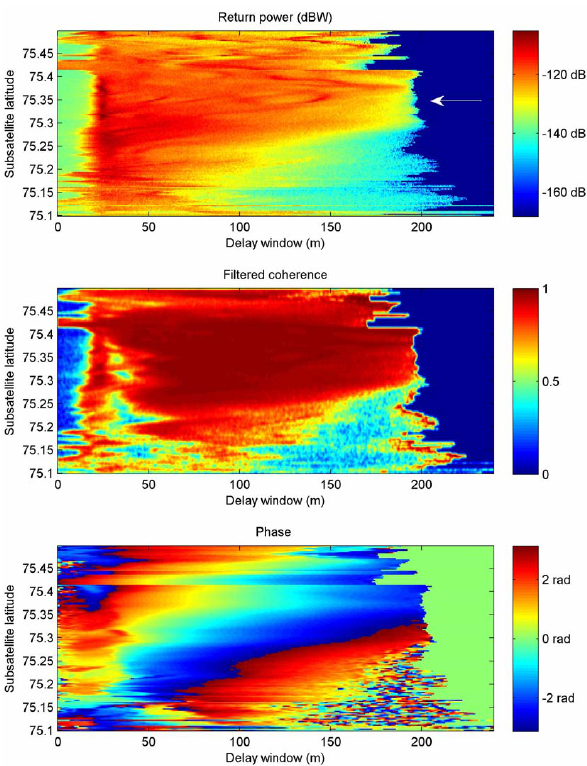
Fig. 5. Illustration of the return power for the central part of the February 23 pass (top), the filtered coherence (middle), and the differential phase (bottom), all as a function of the delay window expressed as a slant range distance. Note that the phase has not been unwrapped at this stage. The white arrow in the upper image of return power indicates the position of the profiles shown in Fig. 6.